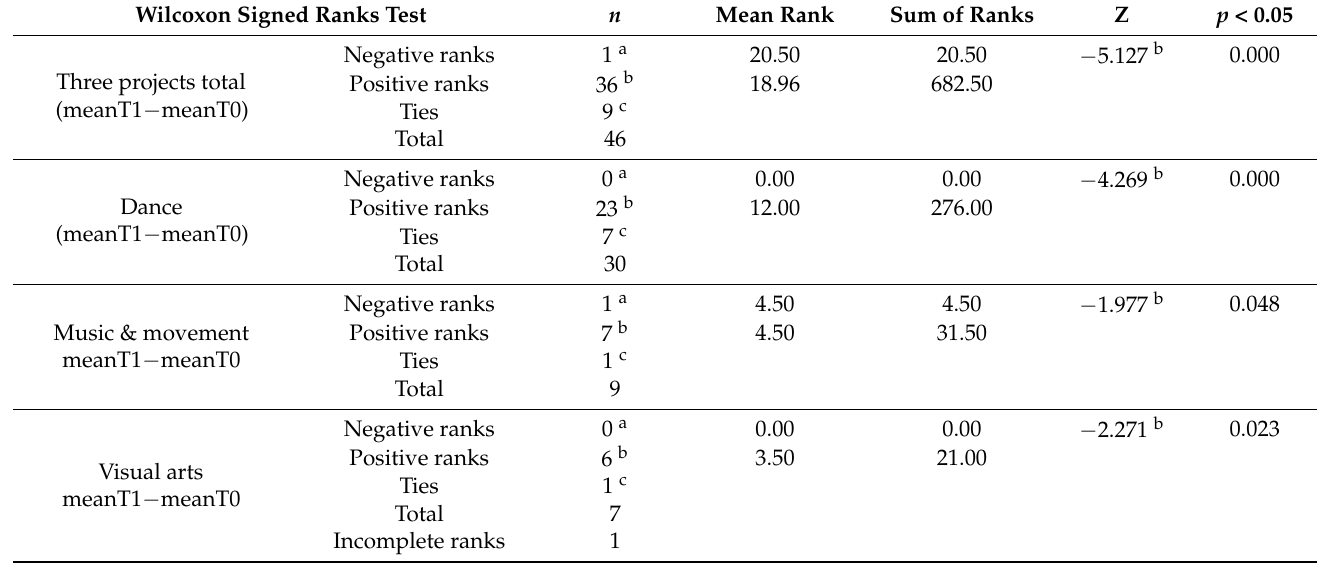
Table 3. Results of the Wilcoxon Signed Ranks